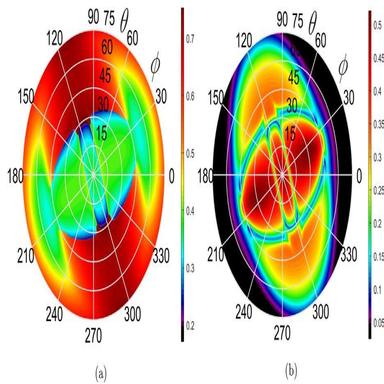
TOF P-UPS plot(a) and amplitude P-UPS plot(b) corresponding to a simulation for an artificial unidirectional plate (d = 1.1 mm). The TOF colorbar is displayed in μs, whereas the amplitude colorbar is normalized to the maximum amplitude of the input signal.